Question: State the chart type depicted above.
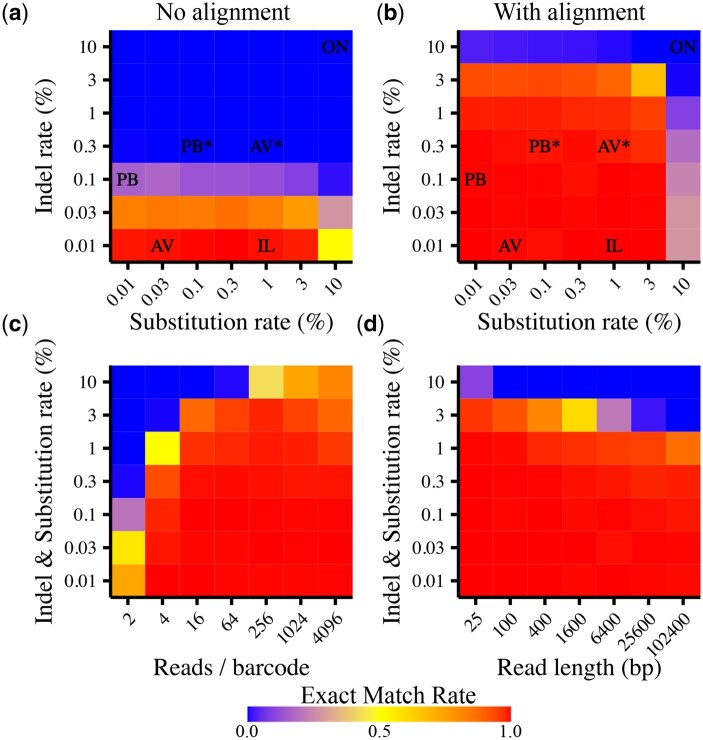
Answer: line